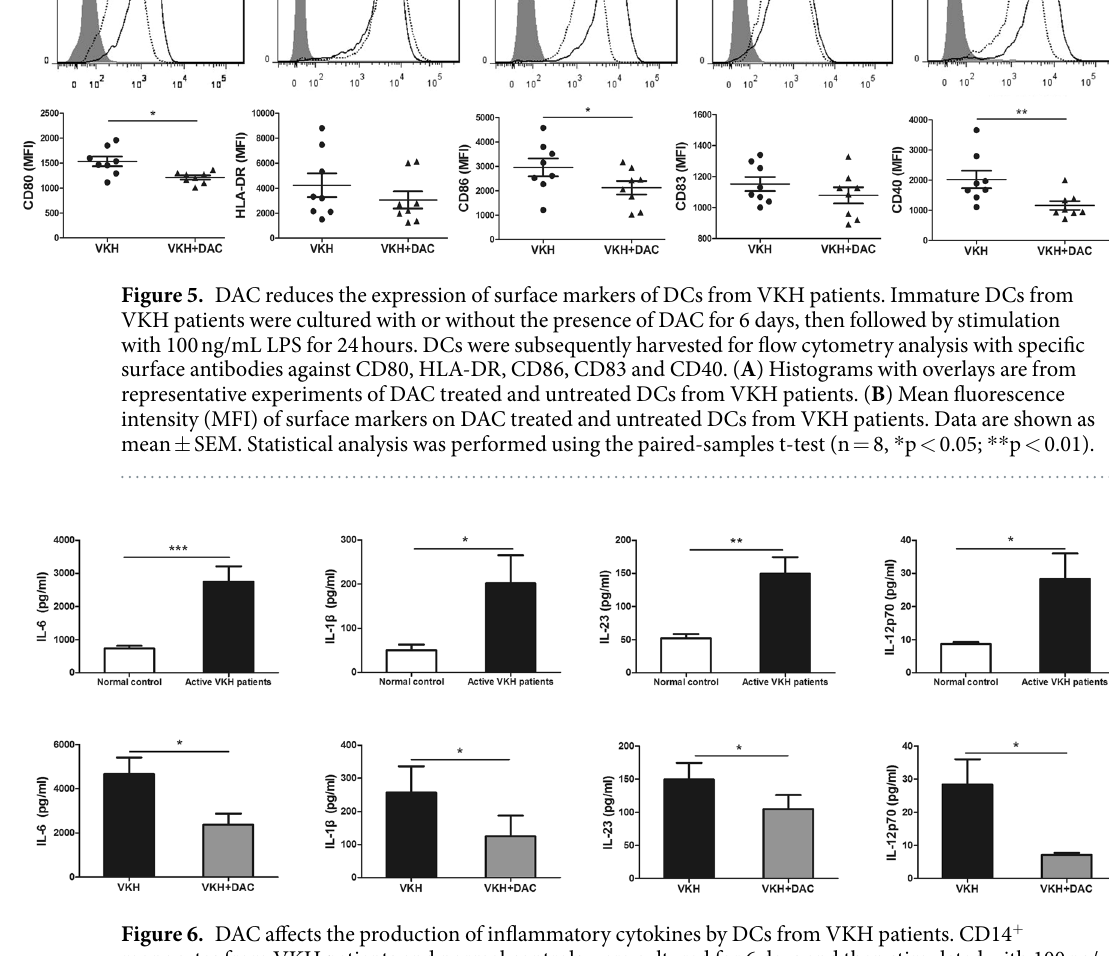
Figure 6. DAC affects the production of inflammatory cytokines by DCs from VKH patients. CD14 + monocytes from VKH patients and normal controls were cultured for 6 days and then stimulated with 100 ng/ ml LPS for 24 hours. The protein concentrations of IL-6, IL-1 β , IL-23 and IL-12p70 in the supernatants were determined by ELISA. ( A ) The expression of IL-6, IL-1 β , IL-23 and IL-12p70 was significantly increased in VKH patients compared with normal controls (n = 12, * p < 0.05, ** p < 0.01, *** p < 0.001). ( B ) The protein concentrations of IL-6, IL-1 β , IL-23 and IL-12p70 were reduced if cells (from VKH patients) were pretreated with 10 µ M of DAC (n = 12, * p < 0.05). The data are shown as mean ± SEM. The paired-samples t-test was performed for the statistical